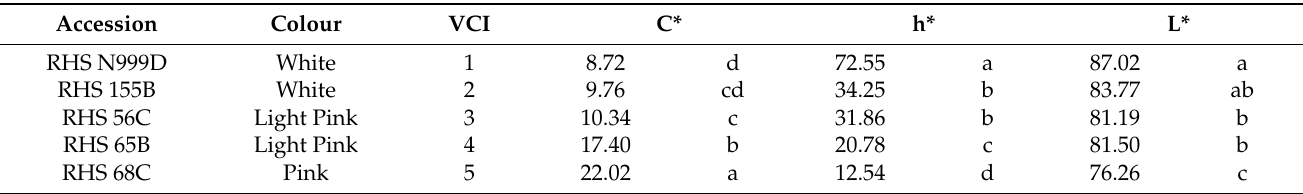
Table 1. Characterisation of the flower colour of five A. pallida accessions including code and colour according to the RHS mini colour chart, and C*, h* and L* values measured with a colourimeter. An arbitrary scale of visual colour intensity (VCI) is also included. Means of 12 replicates are shown, and different letters indicate significantly different values (analysis of variance (ANOVA), p < 0.05).